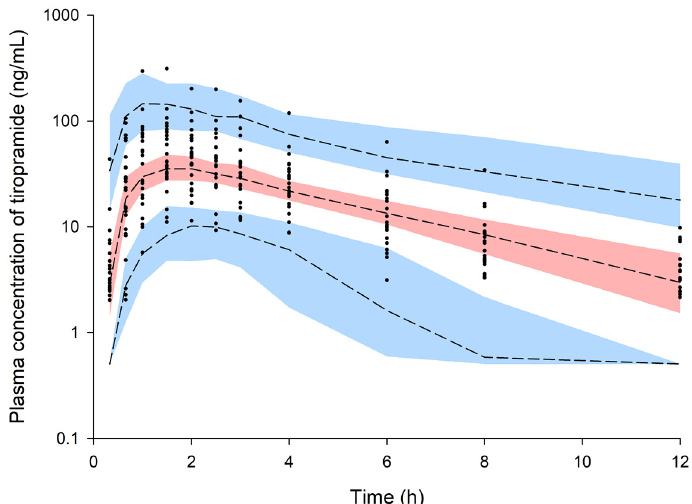
Figure 5. Visual predictive check (VPC) of the final model for tiropramide. Observed concentrations were depicted by the dots. The 95th, 50th, and 5th percentiles of the predicted concentrations are represented by black dashed lines. The 95% confidence intervals (CI) for the predicted 5th and 95th percentiles are represented by the blue shaded regions. The 95% CI for the predicted 50th percentiles are represented by the red shaded regions. The values on the y -axis are logarithms.